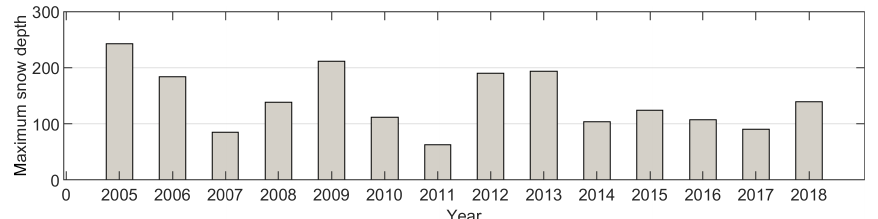
Figure 5. Maximum seasonal snow depths measured at station Kühroint since 2005.